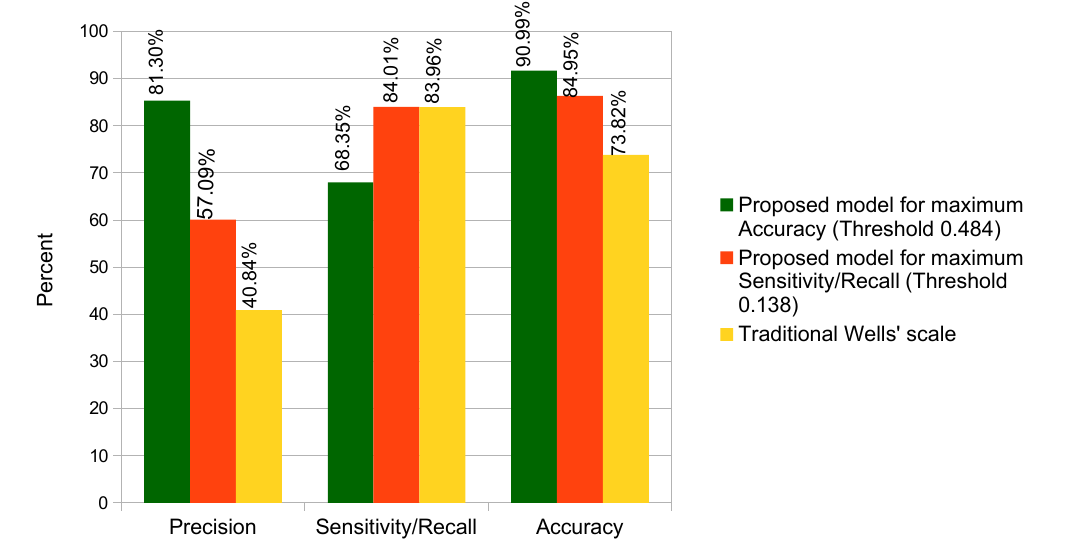
Figure 9. Comparison of the percentages of Precision, Sensitivity/Recall, and Accuracy obtained with the proposed ANN